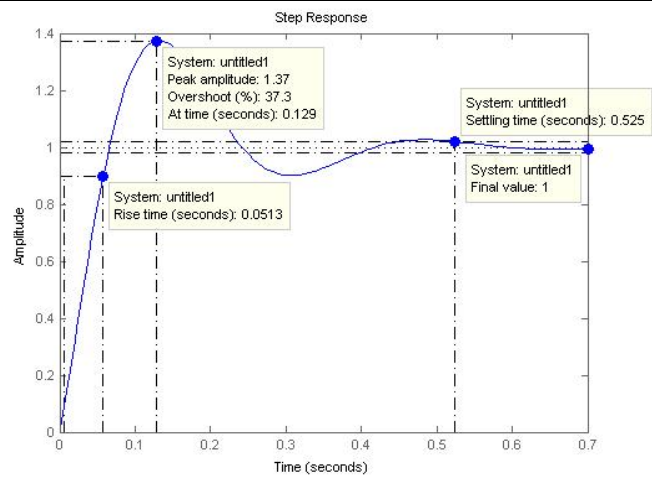
Figure 5: Ziegler Nicholas Simulation model.